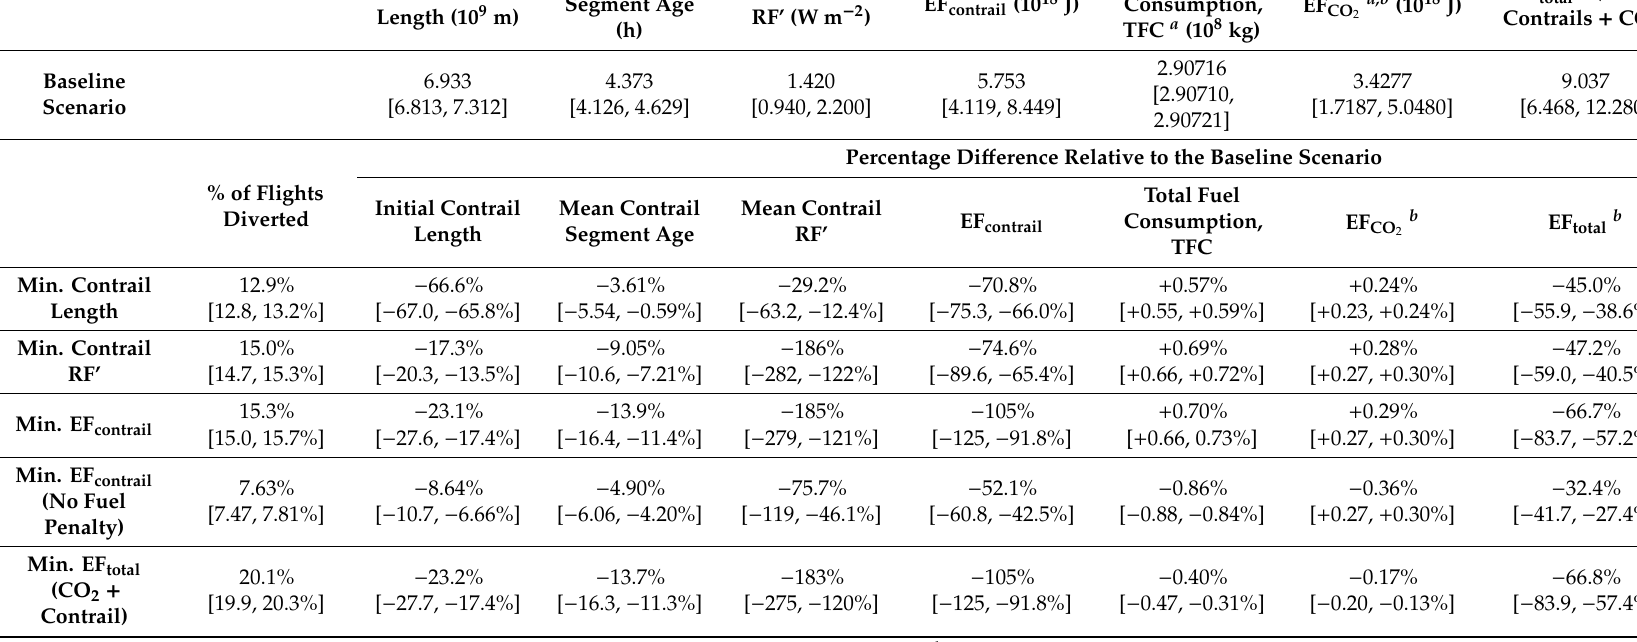
Table 1. Aggregated contrail properties (initial contrail length and mean contrail segment age) and climate forcing (RF’ and EF contrail ), total fuel consumption, EF CO and EF total for the baseline scenario (top); as well as the percentage of flights diverted and percentage di ff erence of these quantities for the five strategies relative to the baseline scenario (bottom). The EF CO and EF total presented in this table are calculated based on a 100-year time-horizon (TH) for the CO 2 AGWP, and the 95% CI is 2 provided in the square